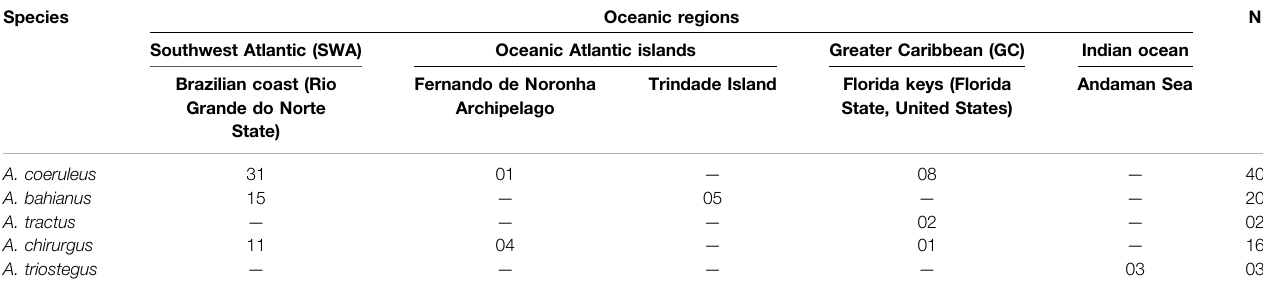
TABLE 1 | Data of the species and populations of Acanthurus (Acanthuridae) used in cytogenetic analyses.